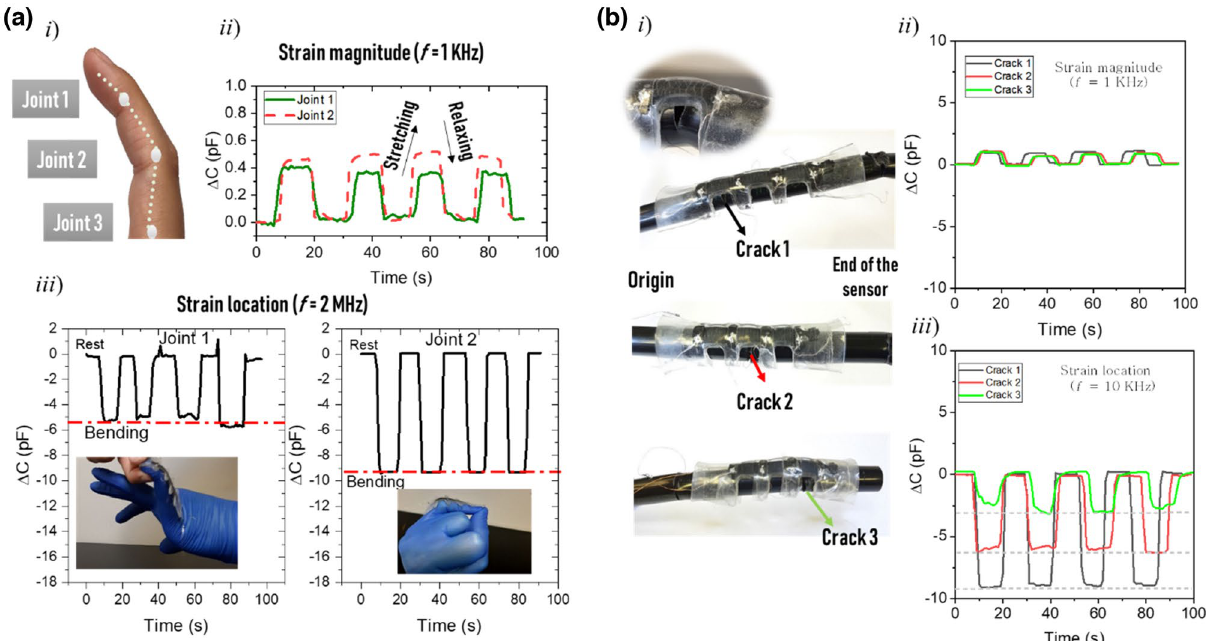
Figure 8. ( a ) Accurate detection of finger-joint motions, showing (i) the joints in the index finger, (ii) strain magnitudes in joints 1 and 2 during four cycles of stretching and relaxing, and (iii) identification of the bent joint from the capacity variation measured at high frequency. ( b ) Detection of crack locations and opening degrees on the nylon tube, showing (i) the photographs of the sensor implemented on a nylon tube with cracks in different locations, (ii) capacity increase realized at a low frequency (1 kHz), representing the strain magnitudes of the three cracks, and (iii) capacitance variations of the cracks at three locations, measured at a high frequency (10